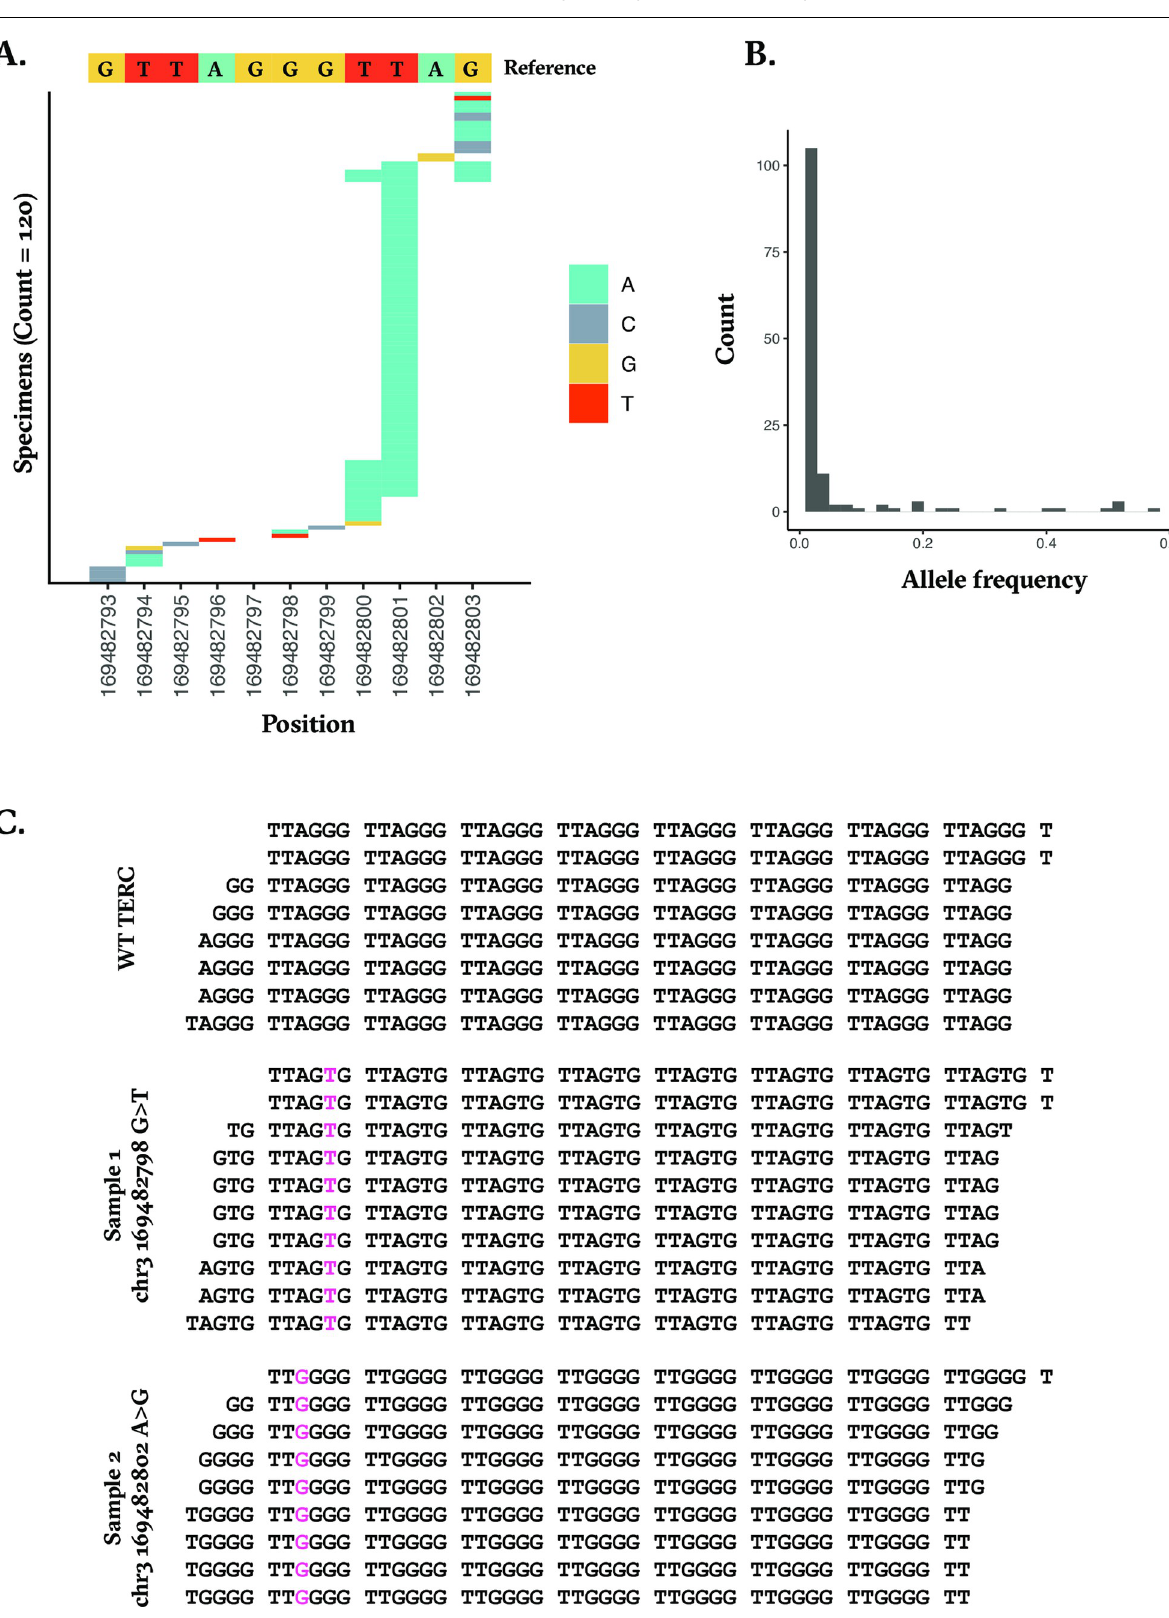
Fig 1. A. Figure depicting the positions along TERC’s template sequence that were mutated in samples across Foundation Medicine’s dataset. B. A histogram of the allele frequencies of the TERC template mutations detected. C. Telomeric reads detected in samples harboring WT TERC , a 169482798 G > T TERC mutation, or a 169482802 A > G TERC mutation. https://doi.org/10.1371/journal.pone.0272707.g001 PLOS ONE | https://doi.org/10.1371/journal.pone.0272707 August 25,